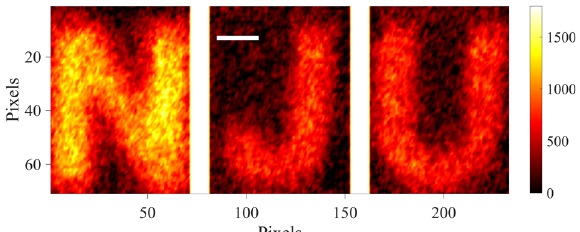
Fig. 4 Interaction-free, single-pixel quantum imaging result of the ‘ NJU ’ plate with undetected photons. The three characters ‘ N ’ , ‘ J ’ , and ‘ U ’ are measured independently with the single-pixel imaging technique. Note that in our experiment, the micromirror of the SLM is rotated 45° at a mount. The edge of SLM can be vaguely seen at the upper left corner of the image. We rotate the reconstructed images by 45° to obtain the above images. The background noise in the signal-photon counts results in some speckles in the recon- structed images. Because of the structural difference of characters and limited detection area of the fi ber-coupled detector, the visual result of character ‘ N ’ is less prominent than ‘ J ’ and ‘ U ’ . The length of the scale bar (white colour) in the fi gure is 500 μ m